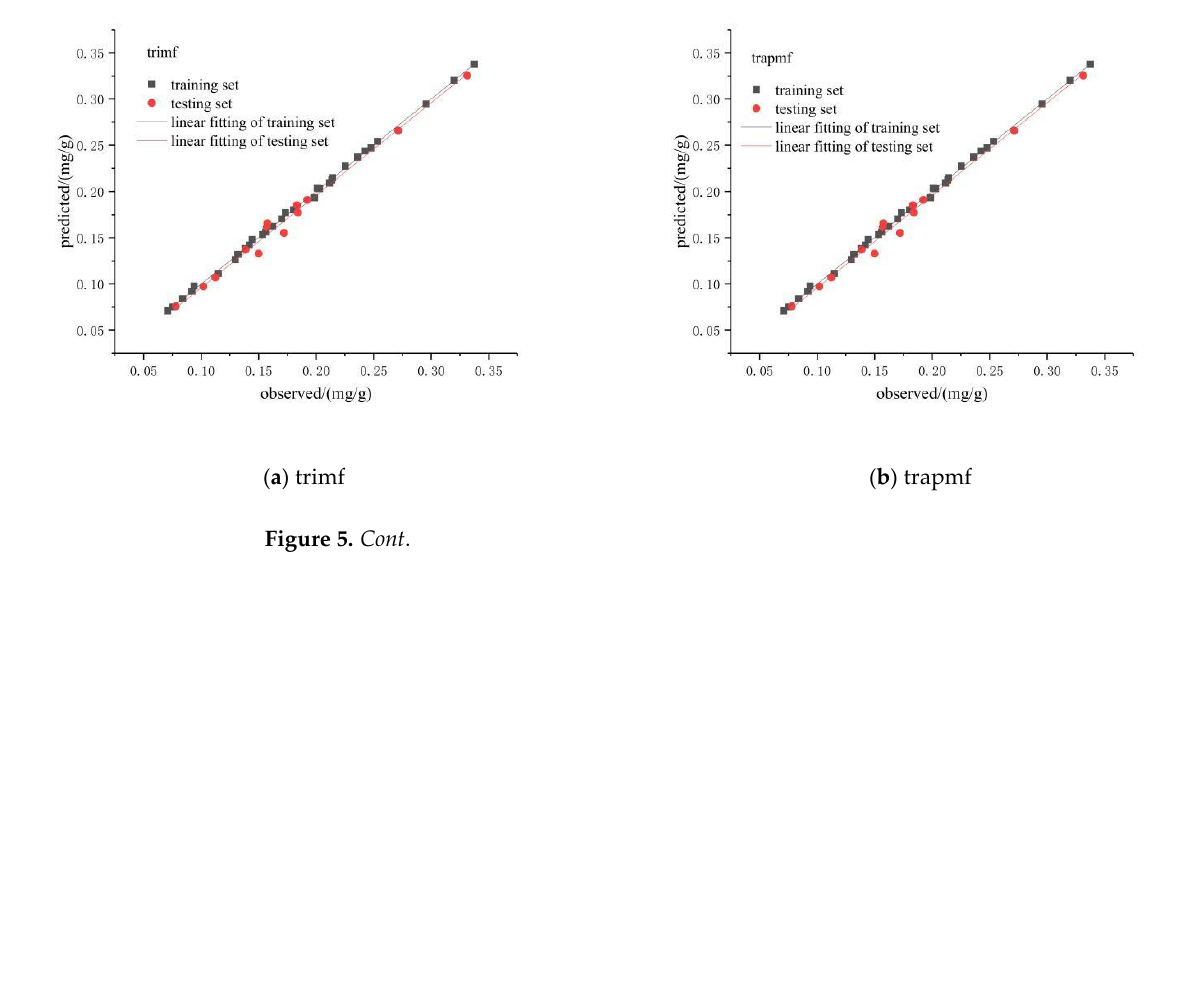
Figure 4. Relationships between observed and predicted values of chlorophyll content in the peri- carp of fragrant pears by the generalized regression neural network (GRNN) model.